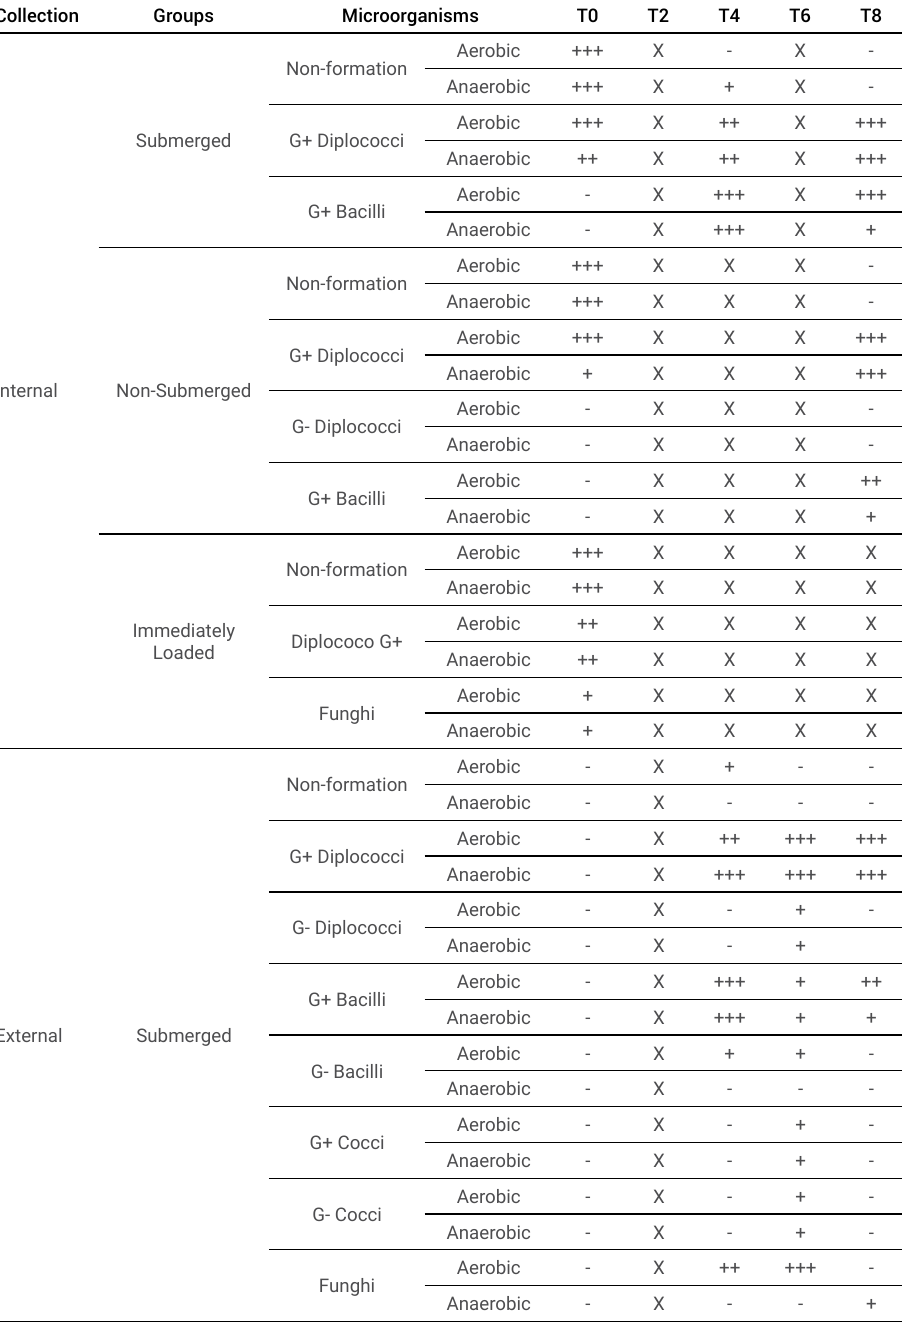
Table 5. Classification of the different types of microorganisms present within groups at the different stages